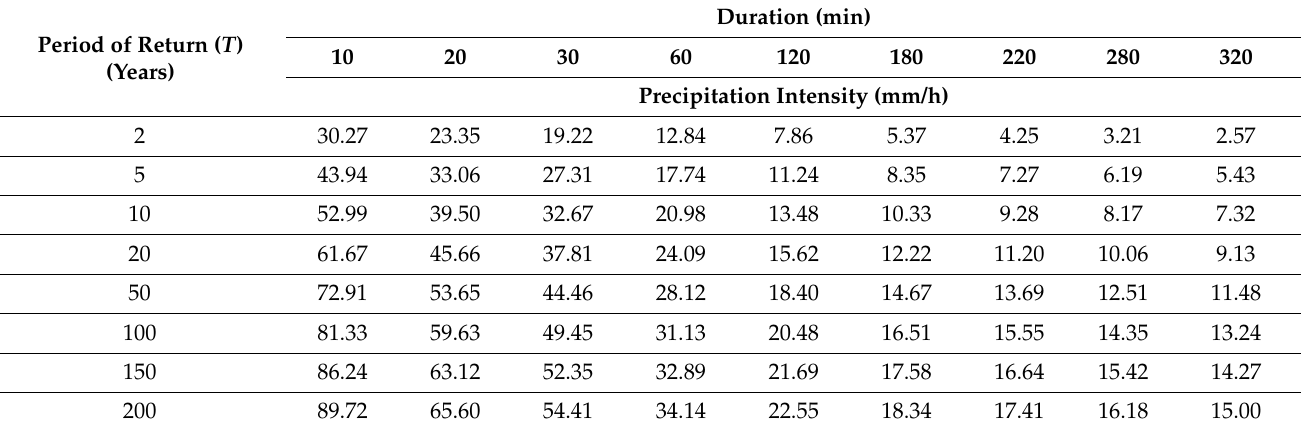
Table 6. Relationship between the return period ( T ) and intensity ( x ( T )